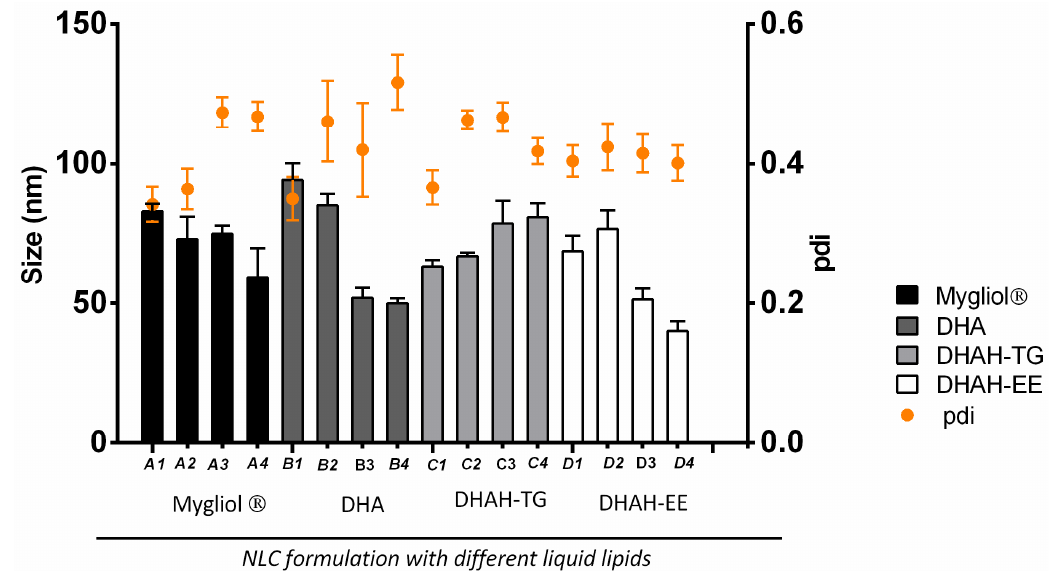
Figure 4. Characterization of the developed nanostructured lipids (NLCs) ( n = 3 for all the nanoformulations).